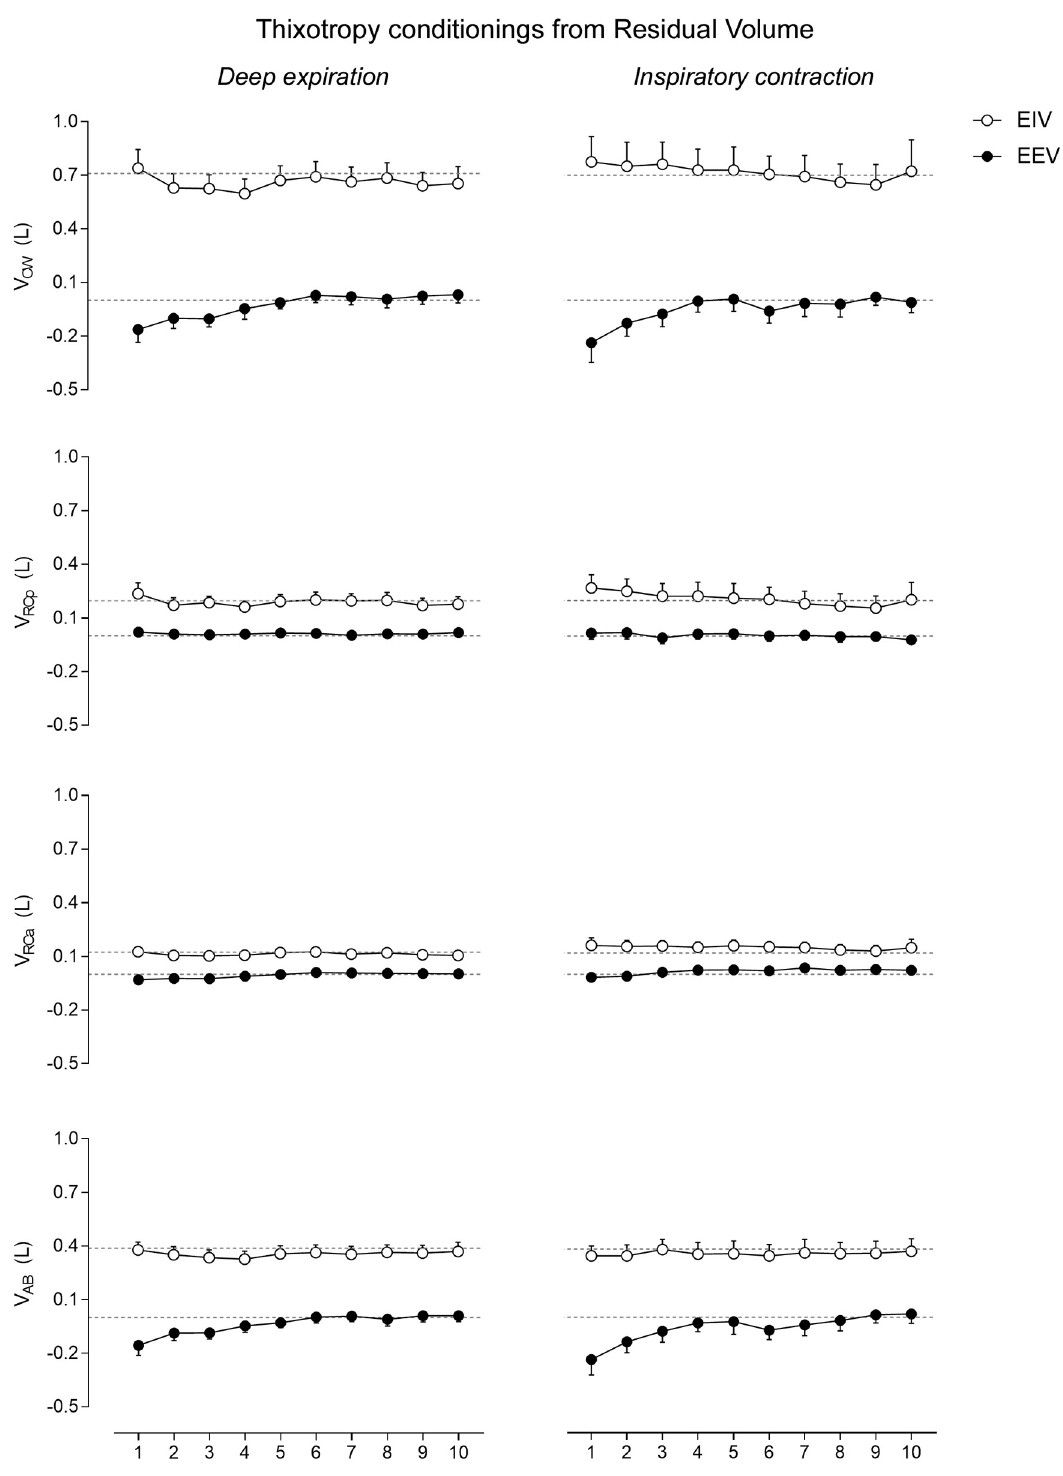
Fig 3. After-effects of thixotropic conditionings performed from residual volume on end-inspiratory (EIV) and end-expiratory (EEV) volumes of the chest wall (CW) and its compartments (pulmonary ribcage [RCp], abdominal ribcage [RCa] and abdominal [AB]). Data of the first ten respiratory cycles (x-axis) immediately after the conditionings were compared with mean values (mean of 60 seconds) of quiet breathing (dotted lines) performed before the maneuvers. Data are shown as mean ± SE. L: Liters.